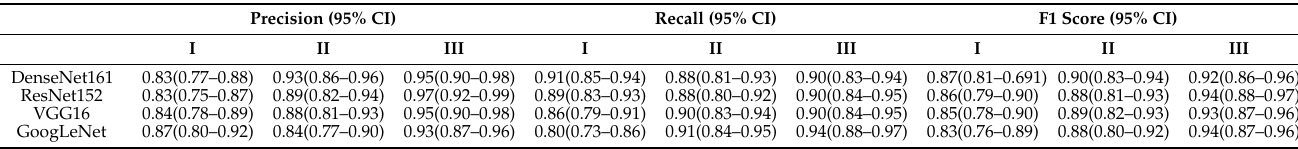
Figure 3. Confusion matrix of the four CNN models of the test set: data concentrating in the diagonal line indicates better predictive performance in the four models. ( a ) DesneNet161; ( b ) ResNet152; ( c ) VGG16; ( d ) GoogLeNet. Table 3. Precision, recall rates, and F1 scores of four CNNs on the test set for each sagittal skeletal pattern